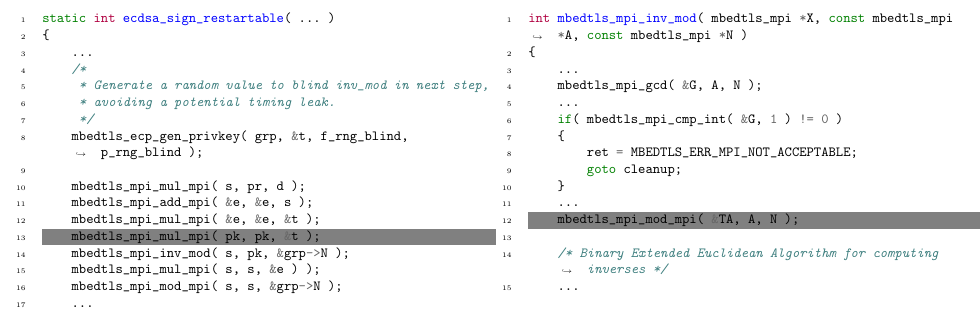
Figure 5: ECDSA nonce blinding countermeasure in